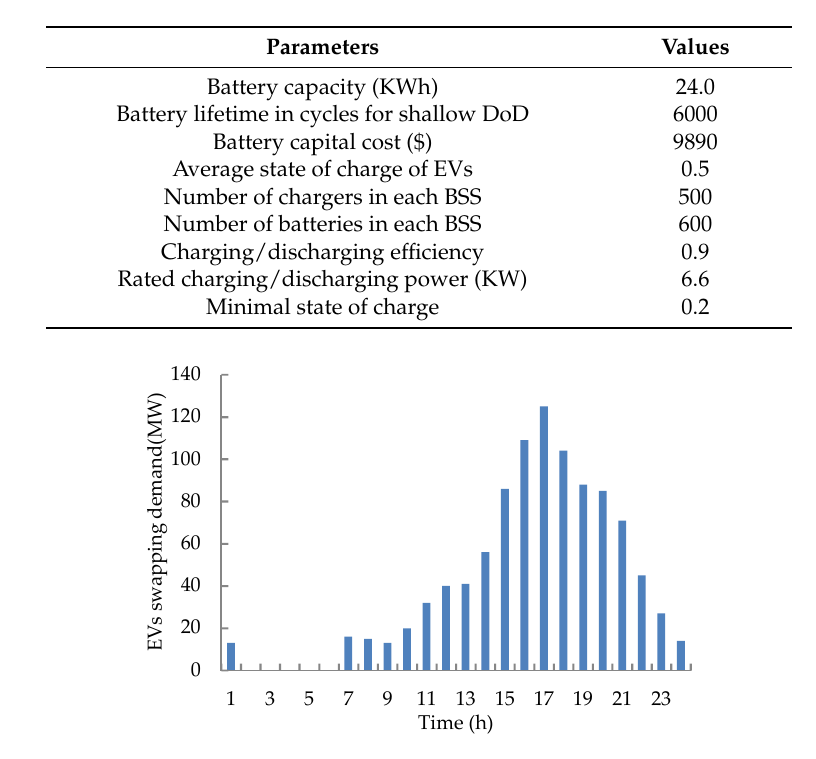
Table 2. Relevant Parameters of BSS S and EV S .